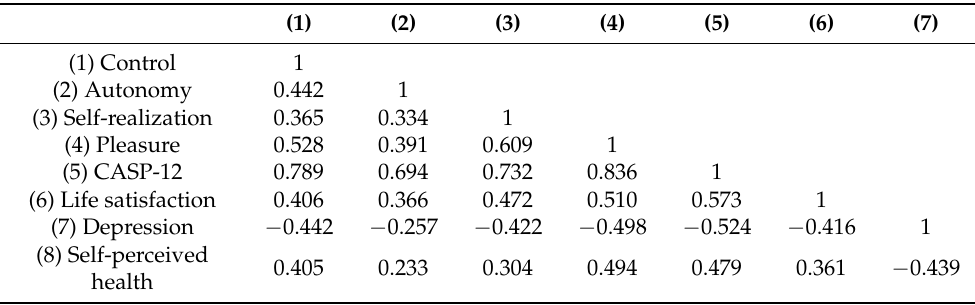
Table 3. Correlations among CASP dimensions, CASP-12 and criteria (all statistically significant p <